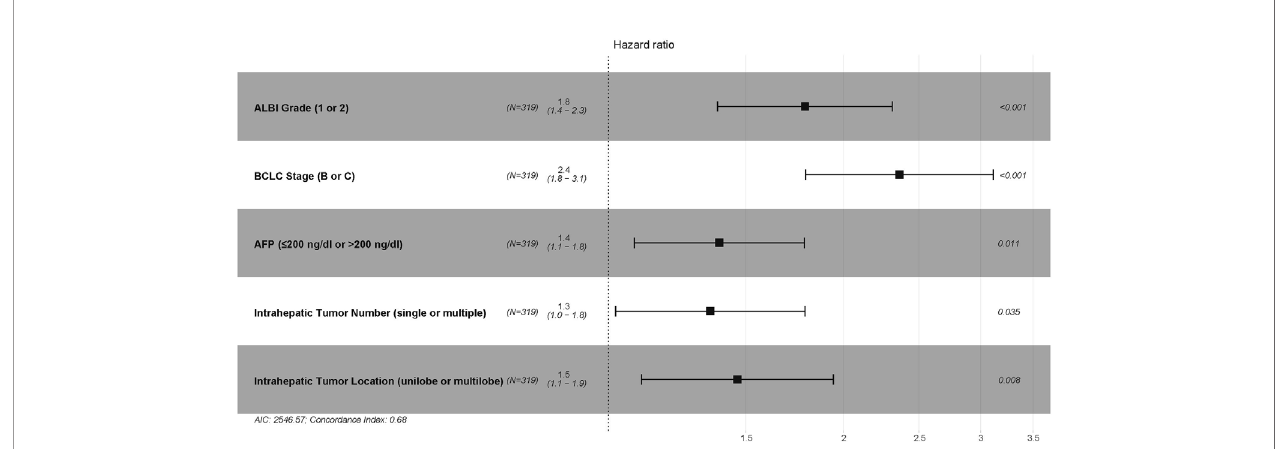
FIGURE 2 | The ALBI-based multivariate Cox proportional hazards regression analysis of risk factors associated with overall survival in the training cohort. ALBI, albumin-bilirubin; BCLC, Barcelona Clinic Liver Cancer; AFP,